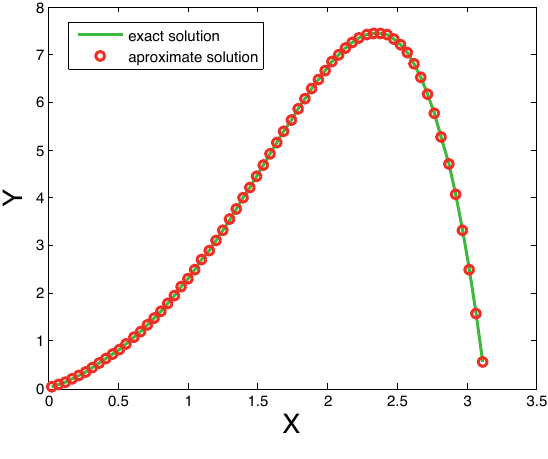
Fig. 2. Comparison of the exact and the approximate solution for Test Problem 2.